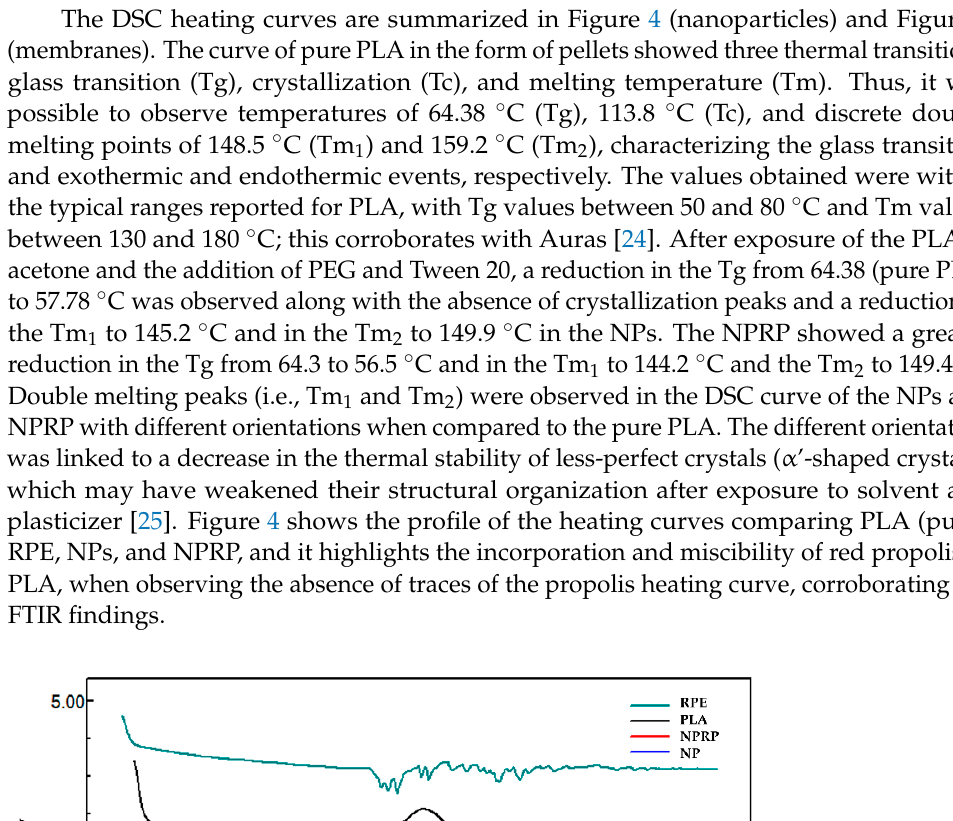
Figure 5. DSC curves of Base M (base membrane-no nanoparticles and no propolis), membrane with NPs, and membrane with NPRP. Characteristic peaks of the melting temperature were identified in both NPs and NPRP, and they suggest the existence of a similar profile in MNP and MNPRP. The melting temperature of MNP and MNPRP was 146.0 and 145.4 °C, respectively. These